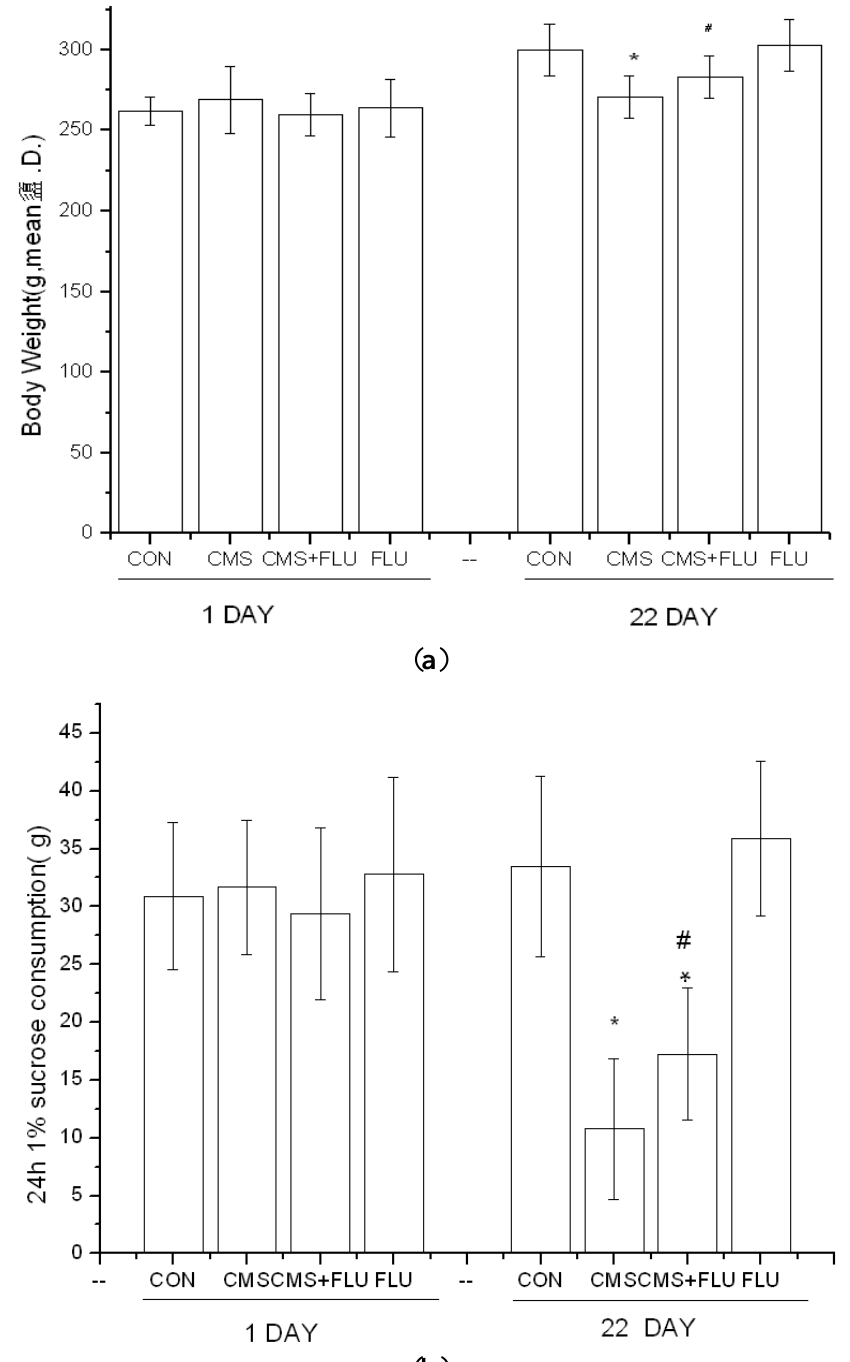
non-stressed group. [ F (3,36) = 7.605, p < 0.001; F (3,36) = 4.132, p < 0.01; F (3,36) = 80.42, p < 0.001; F (3,39) = 98.502, p < 0.001; F (3,36) = 69.369, p < 0.001]. Figure 1. Effects on sucrose consumption, body weight and open field test. * p < 0.001 vs. control, # p < 0.01 vs. CMS (one-way ANOVA followed by Bonferroni test). Results are expressed as mean ± S.D. ( a ) 24 h 1% sucrose consumption of rats before and after CMS; ( b ) Body weight of rats before and after CMS; ( c ) Crossing of rats before and after CMS; ( d ) Rears of rats before and after CMS; ( e ) The urine or excrement frequency of rats before and after